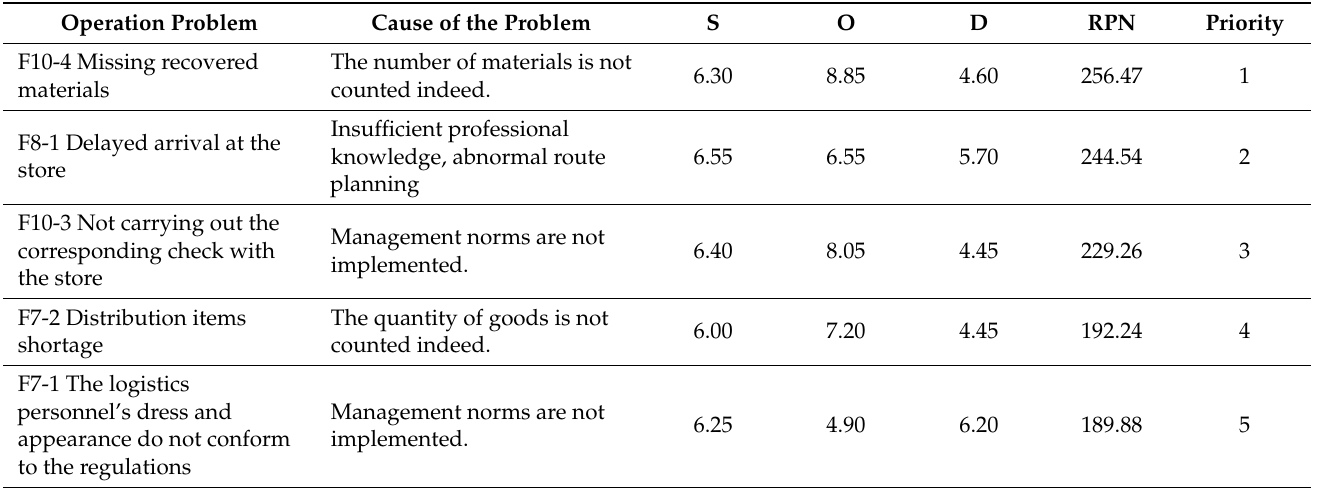
Table 2. The improvement priority of failure model for